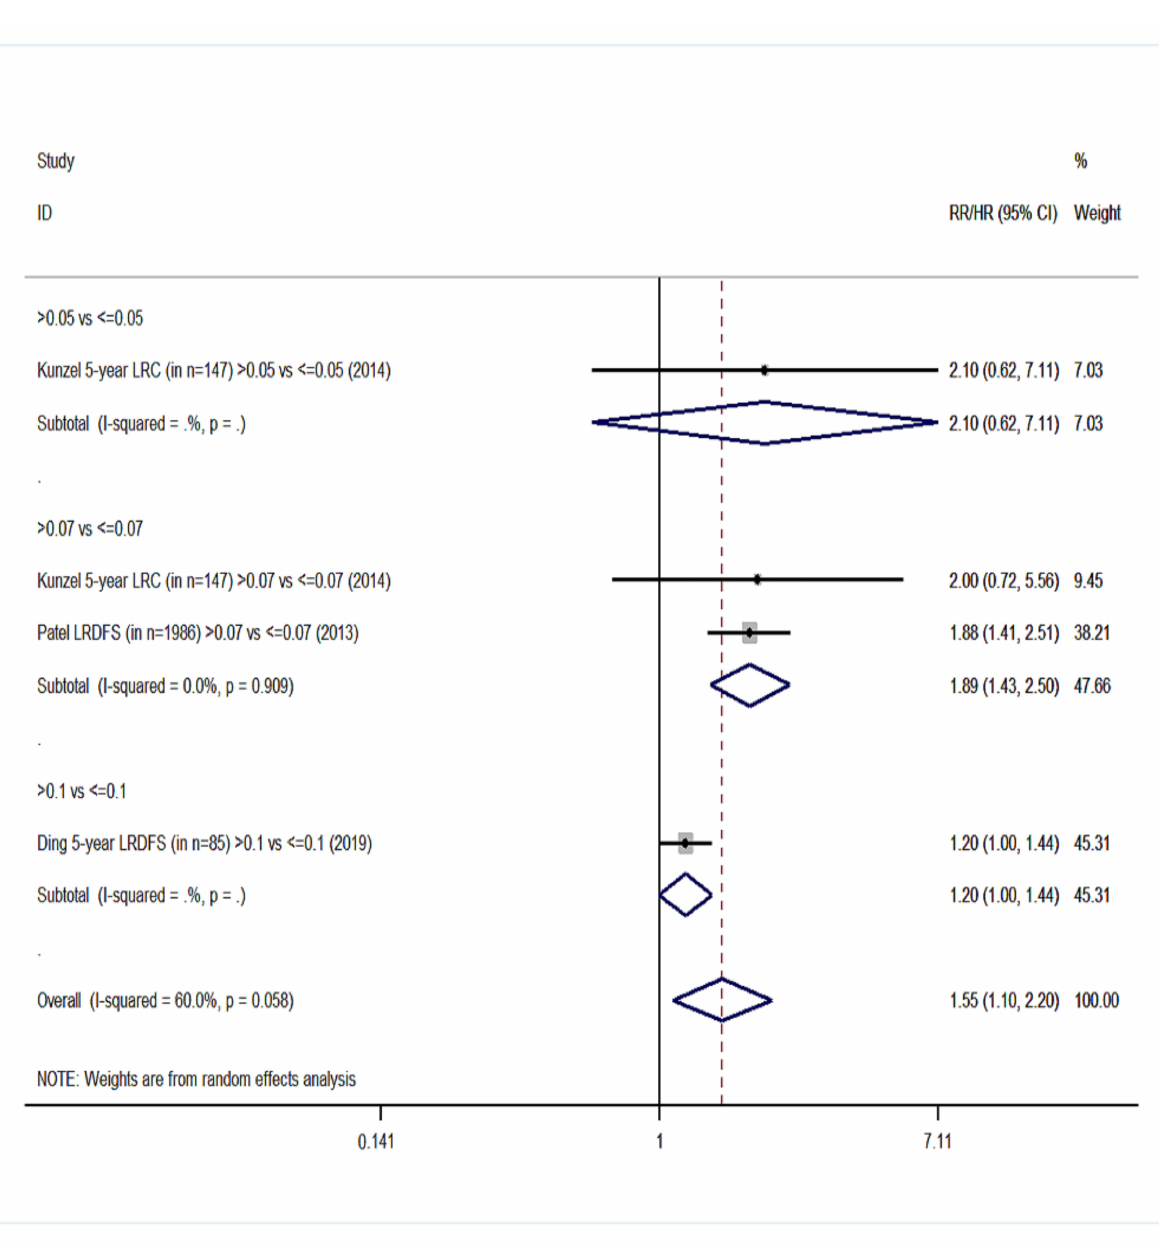
Figure 5. Forest plot demonstrating the associations between lymph node ratio (LNR) and locore- gional disease-free survival (LRDFS) in group YES. Apart from the overall analysis, the subanalyses by LNR cut-off values are